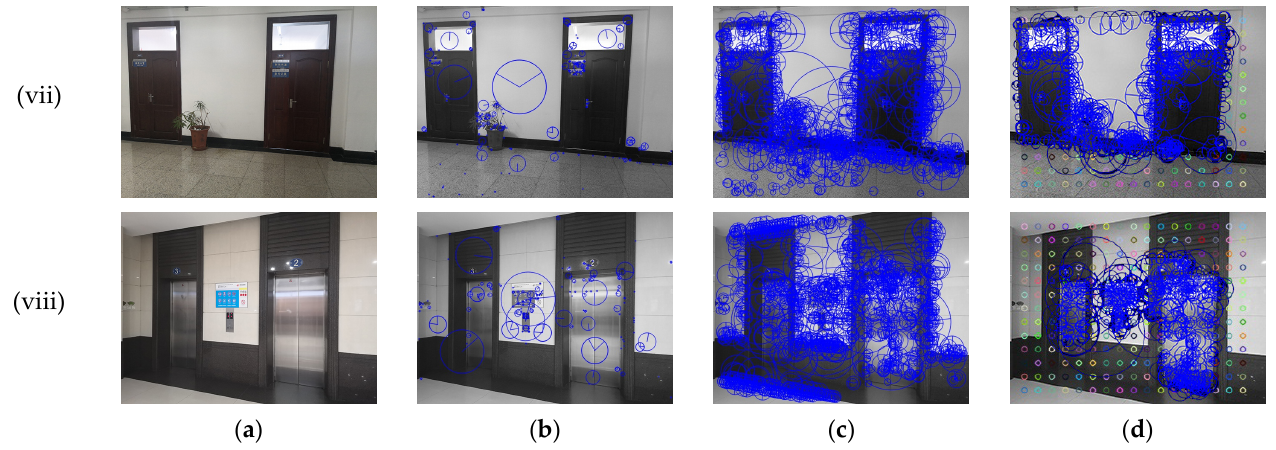
Figure 17. Feature extraction effect comparison. The first group to the eighth group are arranged in order from top to bottom. The feature extraction method for each column is the same: ( a ) origin images; ( b ) features extracted by SIFT; ( c ) features extracted by SURF; ( d ) features extracted by ARAC.